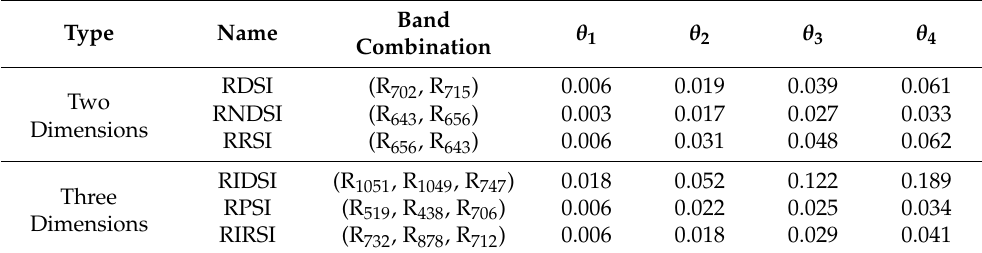
Table 2. The thresholds of the sensitive RISIs and band combinations.